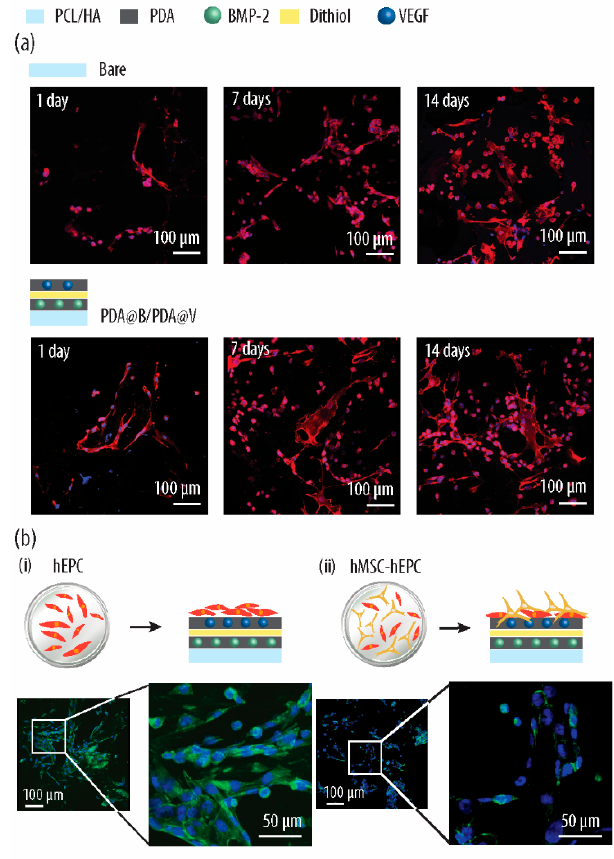
Figure 6. ( a ) Merged confocal laser scanning microscopy (CLSM) images of co-cultured human mesenchymal stem cells (hMSCs) and human endothelial progenitor cells (hEPCs) onto uncoated PCL/HA scaffolds (bare) or coated (PDA@B/PDA@V) scaffolds for 1, 7 and 14 days, respectively: the actin filaments have been stained with palloidin-TRITC (red fluorescence signal), and the nuclei have been stained with DAPI (blue fluorescence signal). ( b ) Merged CLSM images of monocultured hEPCs ( i ) and co-cultured hMSCs and hEPCs ( ii ) onto coated (PDA@B/PDA@V) scaffolds for 14 days: platelet endothelial cell adhesion molecule (PECAM-1) has been stained with Alexa Fluor 488 (green fluorescence signal), and the nuclei has been stained with DAPI (blue fluorescence signal). The PDA@B/PDA@V coating consists of two polydopamine (PDA) layers connected by a dithiol linker and entrapping BMP-2 (B) and VEGF (V) growth factors within the first and second PDA layers, respectively.